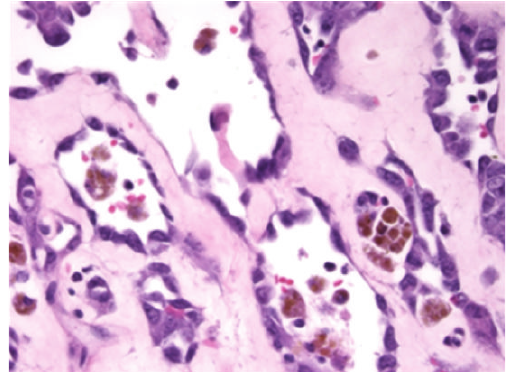
Figure 2: Prominent vasoformative architecture, as depicted in this radiation-associated angiosarcoma of the breast, was seen in the majority of the radiation-associated tumors in this study (H&E,